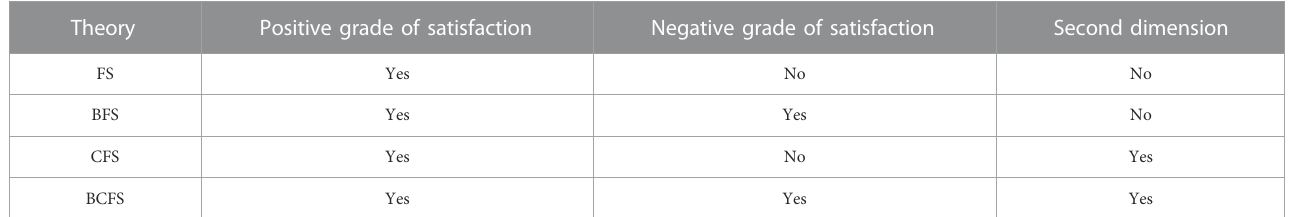
TABLE 1 Comparison of BCFS with certain prevailing theories.